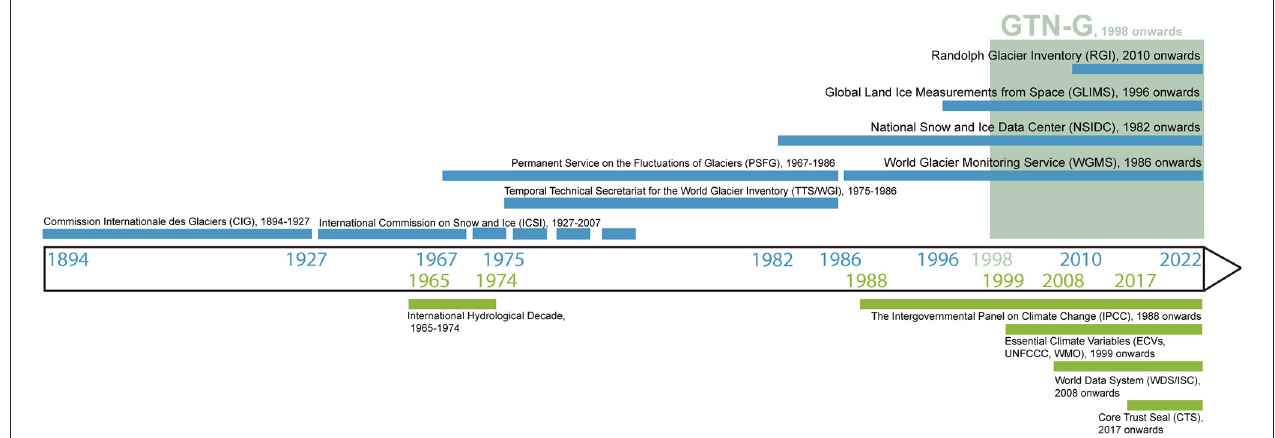
FIGURE 2 | Timeline related to the operational bodies and partners within GTN-G and their predecessor bodies (blue bars), as well as influencing international efforts in relation to use and valorization of glacier data (green bars). Figure modified after Allison et al. (2019).